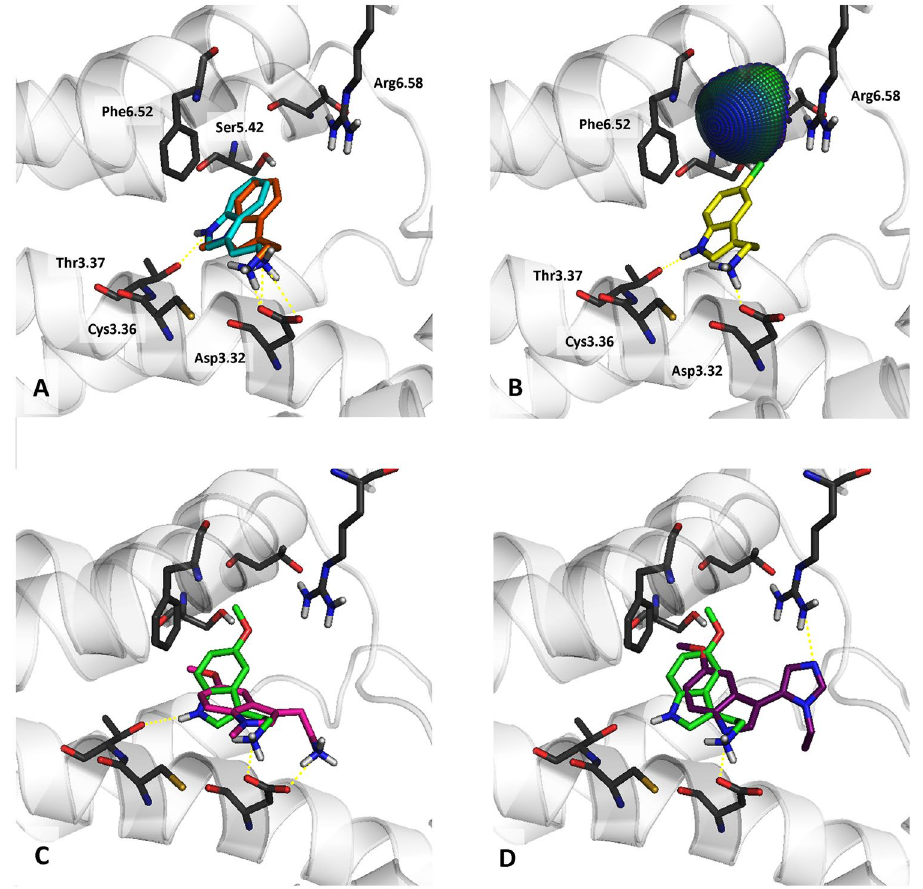
Figure 8. Representative complexes of selected tryptamines with 5-HT 7 receptor. Amino acids that were selected as crucial for the binding of the presented compounds are shown as sticks. ( A ) – the superposition of tryptamine (cyan) and 1-methyltryptamine (orange). ( B) – the halogen bond formed between Ser5.42 and 5-chlorotryptamine (yellow). ( C ) – the superposition of 5-methoxytryptamine (green) and 1-methyl- 5-methoxytryptamine (magenta). ( D ) – a comparison of the binding modes of 1f (violet) and the analogous